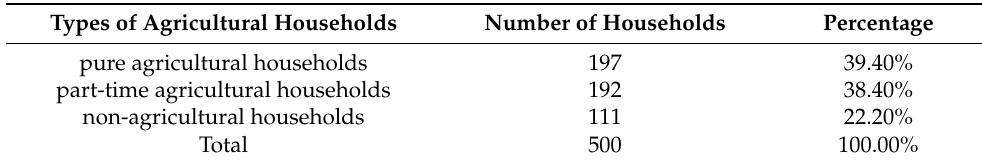
Table 2. Statistics on the types of agricultural households. Types of Agricultural Households Number of Households Percentage pure agricultural households 197 part-time agricultural households 192 non-agricultural